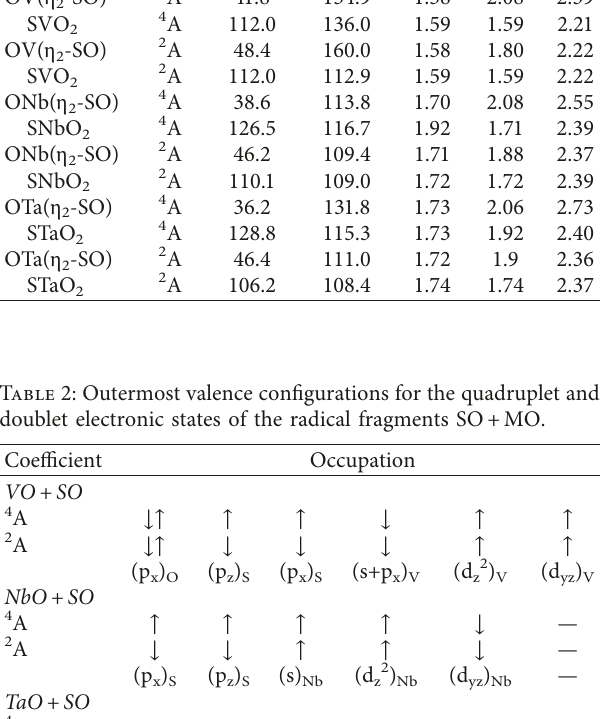
2 -SO) and the sulfide oxide η